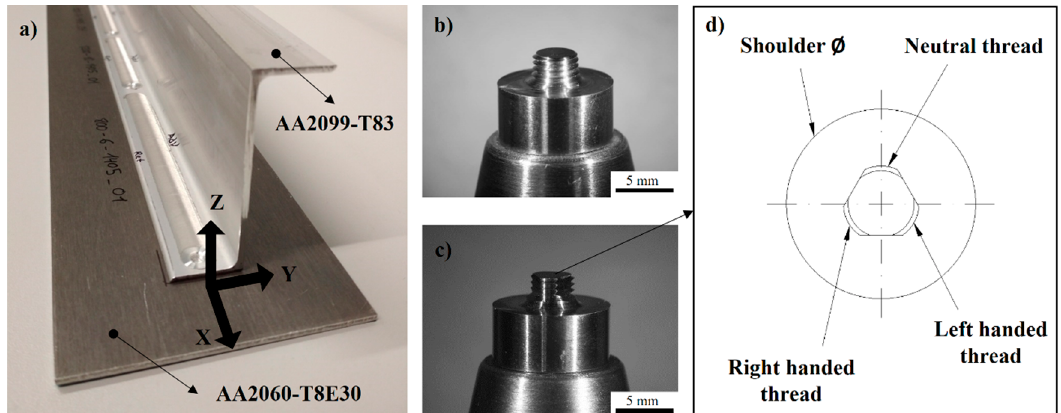
Figure 1. ( a ) Friction stir welding (FSW) lap joint between AA2099-T83 extrusion and AA2060-T8E30 sheet and FSW tools used to produce them; ( b ) conventional threaded tool; ( c ) 3 flats + mixed thread tool; and ( d ) sketch showing details of the top view of the 3 flats + mixed thread tool.